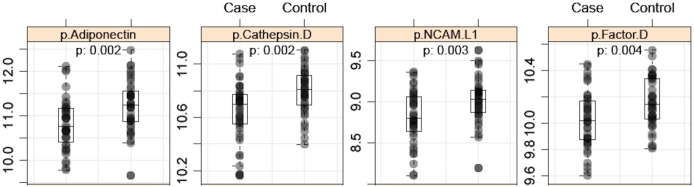
Scatterplot of diagnostic protein biomarkers.Circulating levels of top-ranked diagnostic biomarkers in IGT subjects (case, left) compared to healthy controls (right).